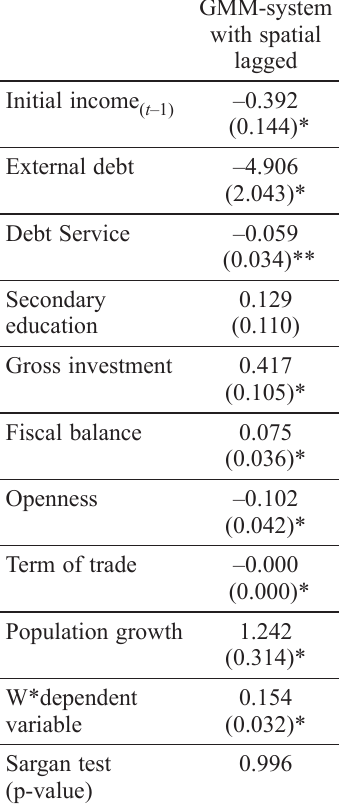
Table 4. Impact of external debt on growth in spatial